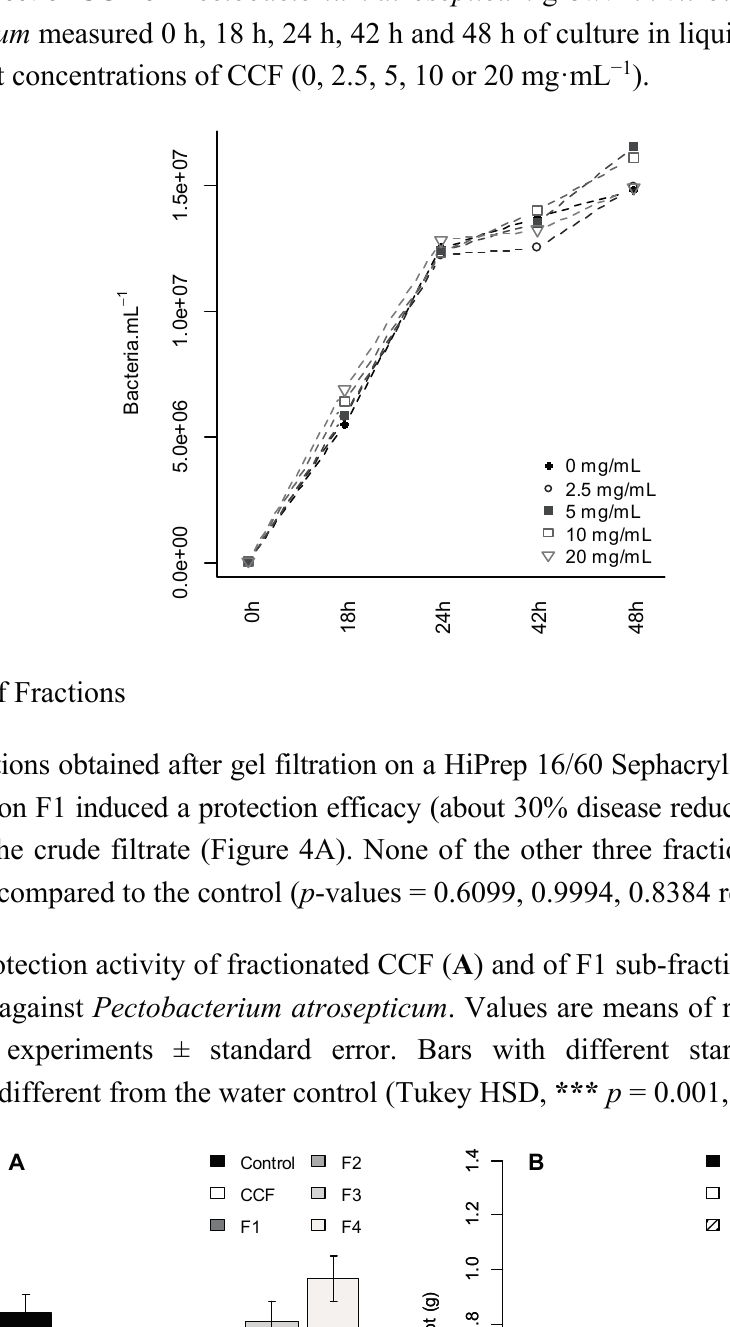
Figure 3. Effect of CCF on Pectobacterium atrosepticum growth in vitro . Concentration of P. atrosepticum measured 0 h, 18 h, 24 h, 42 h and 48 h of culture in liquid media enriched